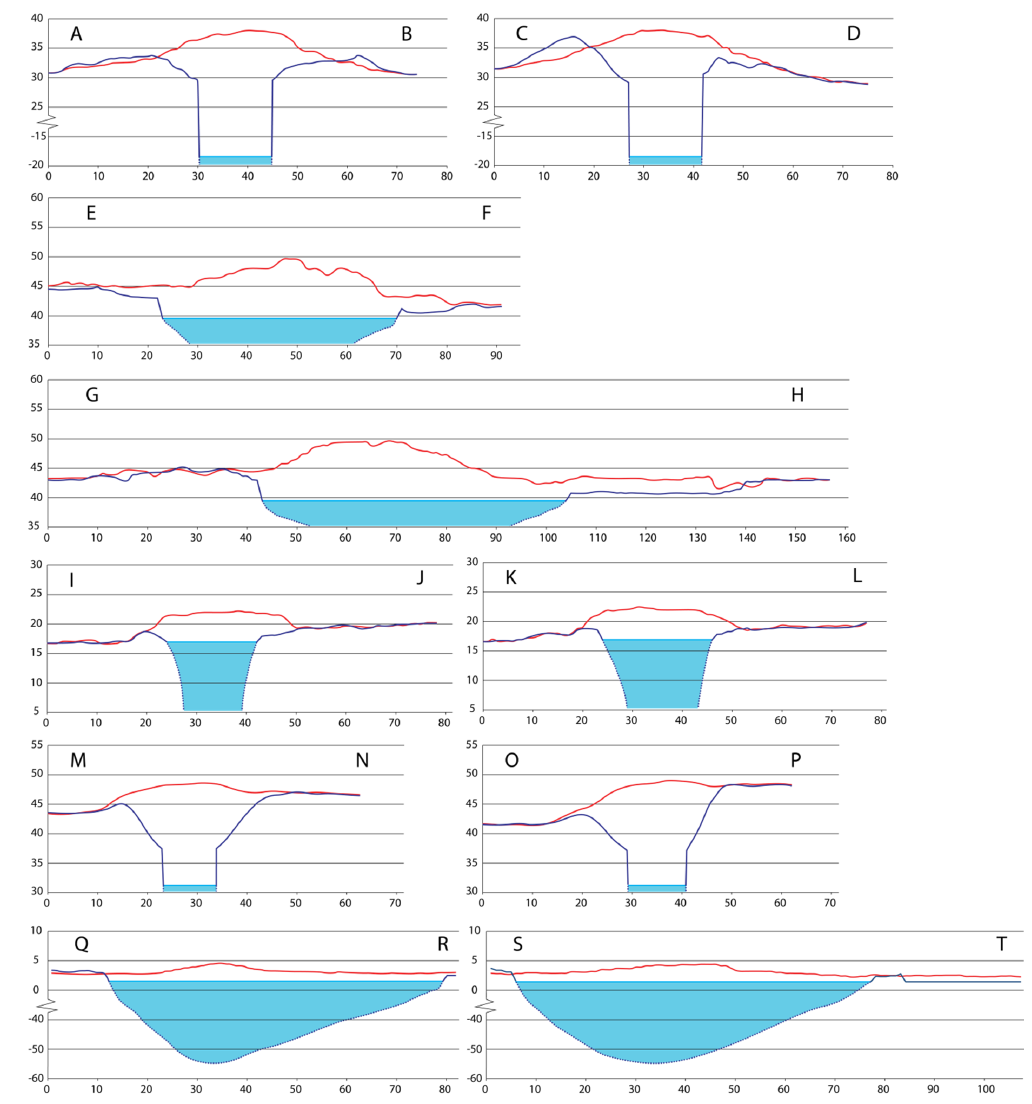
Figure 5. Elevation profiles across mound-predecessors and gas emission craters. Profile locations are shown in Figure 4. Profiles were plotted across GEC-1 (AB, CD), GEC-2 (EF, GH), GEC-3 (IJ, KL), and AntGEC (MN, OP) using the created DSMs, listed in Table 1. Profiles across SeYkhGEC (QR, ST) were plotted using 2-m spatial resolution ArcticDEM Stripes created based on images dated 19 April 2016 and 27 June 2017. The red line reflects the morphology of mound-predecessors, and the cyan line shows the morphology of GEC on dates closest to GEC formation as shown in Table 1. The light-blue shaded area presents a lake formed inside the GEC. Lake depth is obtained in the field. SeYkhGEC in the riverbed of the Myudriyakha river is shown to exceed 50 m in depth according to [7].